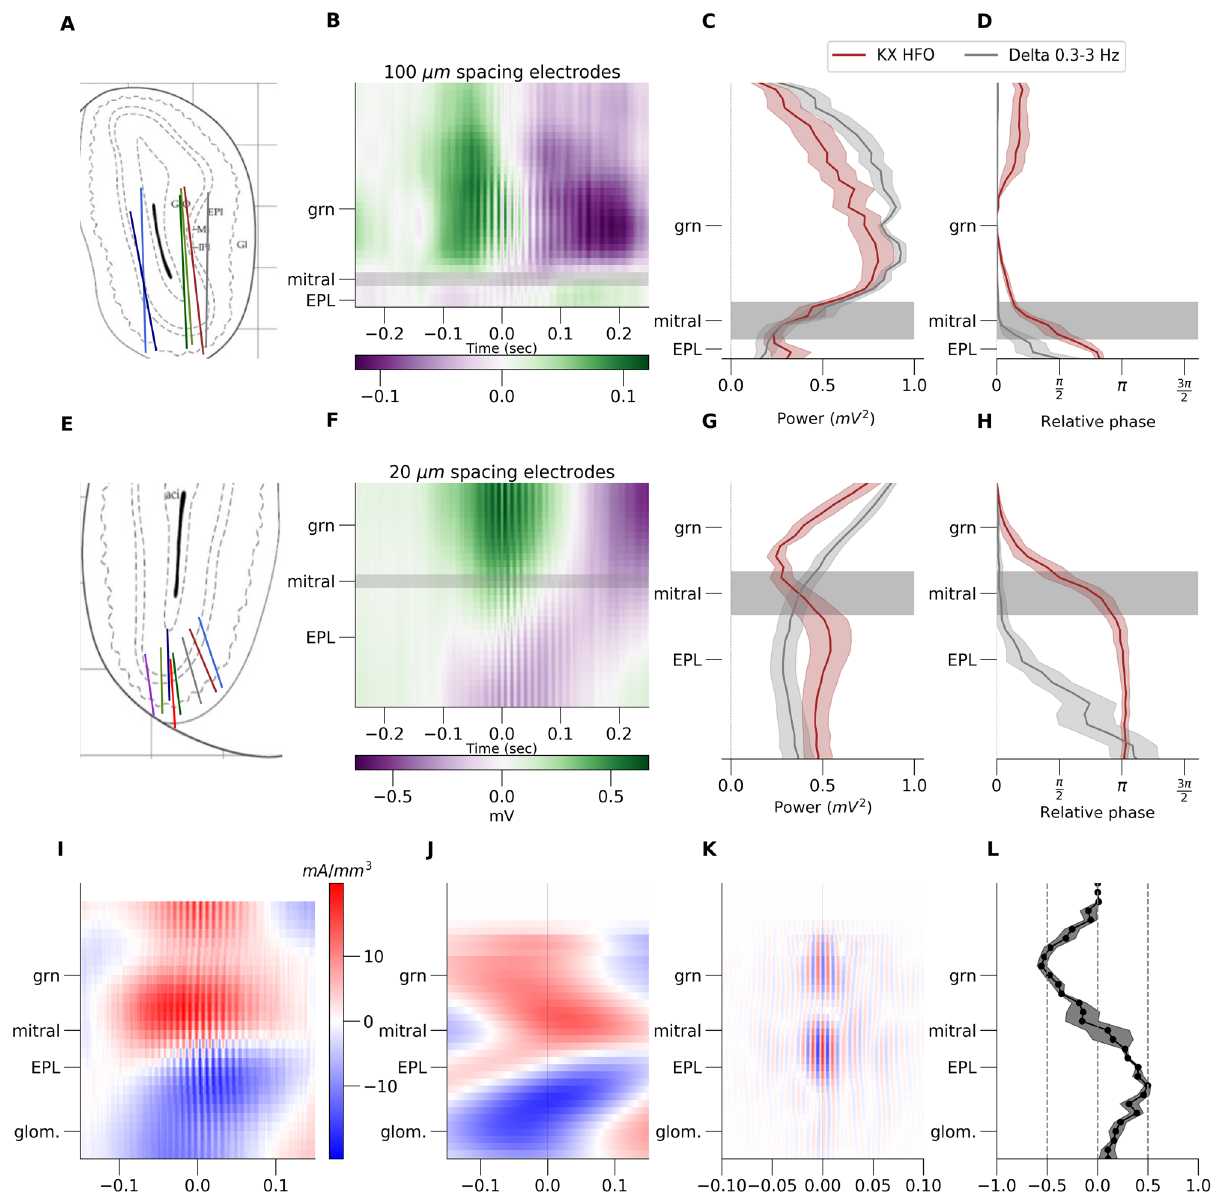
Figure 3. Depth profile of KX-dependent 80–130 Hz oscillations in the rat OB using 32 channel linear silicon probes. Results presented in ( A – D ) were obtained using 3.2 mm electrodes with 100 μm inter-electrode distance. ( A ) Histology illustration based on n = 6 rats OB staining. ( B ) Example raw LFP from 32 channels (y axis). Colorbar scale is in mV. ( C ) Depth profile of 80–180 Hz power from all 32 channels. Power decreases around mitral layer. x-scale is in mV 2 ( D ) Phase of 80–130 Hz oscillations which changes phase around mitral layer. Delta changes phase below the mitral. x-scale is in degrees. Results presented in ( E – H ) were obtained using 32 channel electrodes with an intercontact distance of 20 μm, and spanning 0.64 mm. Analyses for this data are the same as in ( A – D ) (n = 8). Results presented from ( I – K ) shows CSD analysis for 20 μm spacing electrode. ( I ) raw example CSD. ( J ) CSD filtered in 0.3–3 Hz band. Plots were then aligned in respect to the histology and averaged across rats n = 8. ( K ) CSD filtered in 80–130 Hz band ( L ) Average correlation plot between of local HFO and MUA density (n = 4). grn granule layer, EPL extraplexiform layer and glom. glomerulur